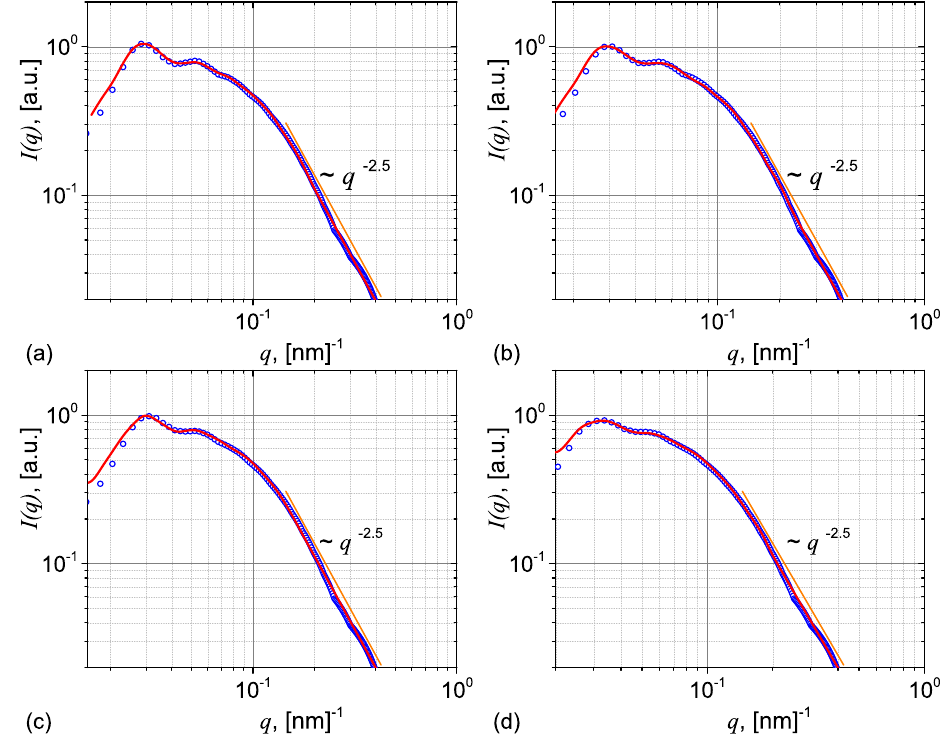
Figure 6. (Color online) Scattering intensities for systems S1 ( a ), S2 ( b ), S3 ( c ) and S4 ( d ). Blue = discrete dots: Monte Carlo simulations; Red = continuous line: Fit with model given by Equation